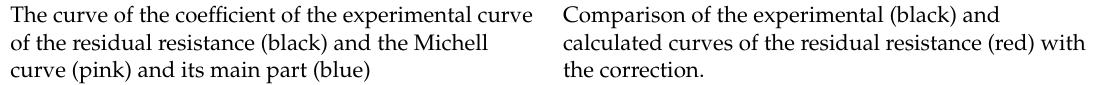
curve (pink) and its main part (blue) Michell